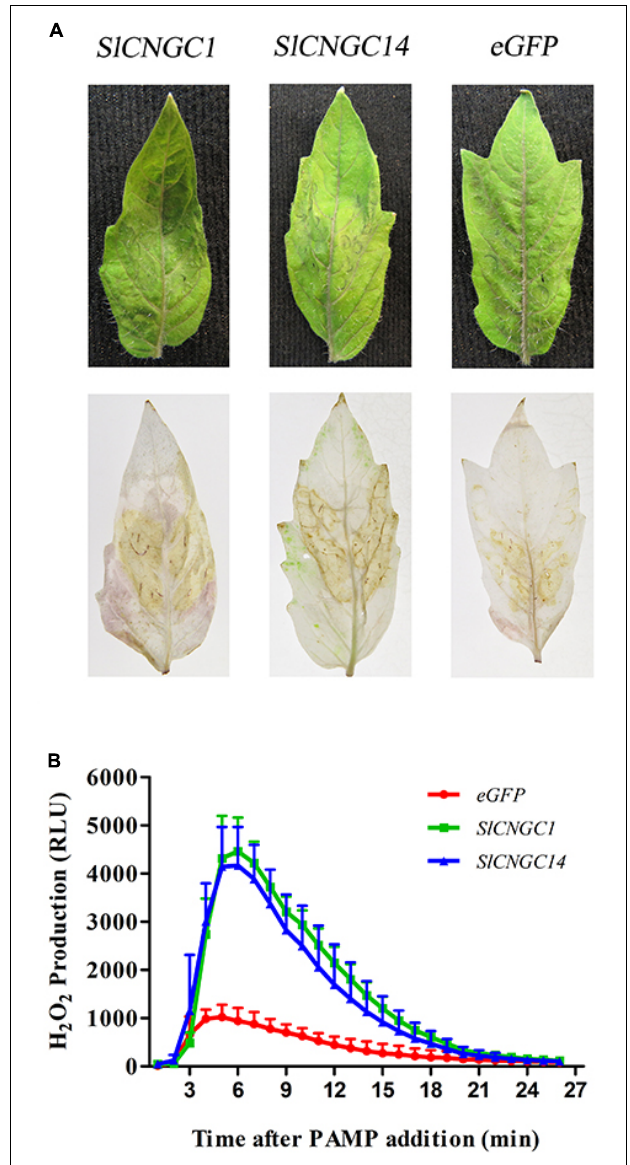
FIGURE 3 | Silencing of SlCNGC1 and SlCNGC14 promoted Xoc -induced and flg22-elicited ROS accumulation. (A) Xoc -induced ROS assay. Hydrogen peroxide (H 2 O 2 ) accumulation at 4 hpi was detected through Diaminobenzidine (DAB) staining analysis. The Xoc -infriltrated leaves before (Up panel) and after (Down panel) staining analyses were presented. (B) flg22-elicited ROS assay. Production of H 2 O 2 induced by 100 nM flg22 was detected using a luminol-based assay in leaf disks of SlCNGC1 -, SlCNGC14 -silenced plants and the eGFP non-silenced control plants. Data are shown as relative luminol units (RLUs) and represent the mean ± SE of three independent experiments.